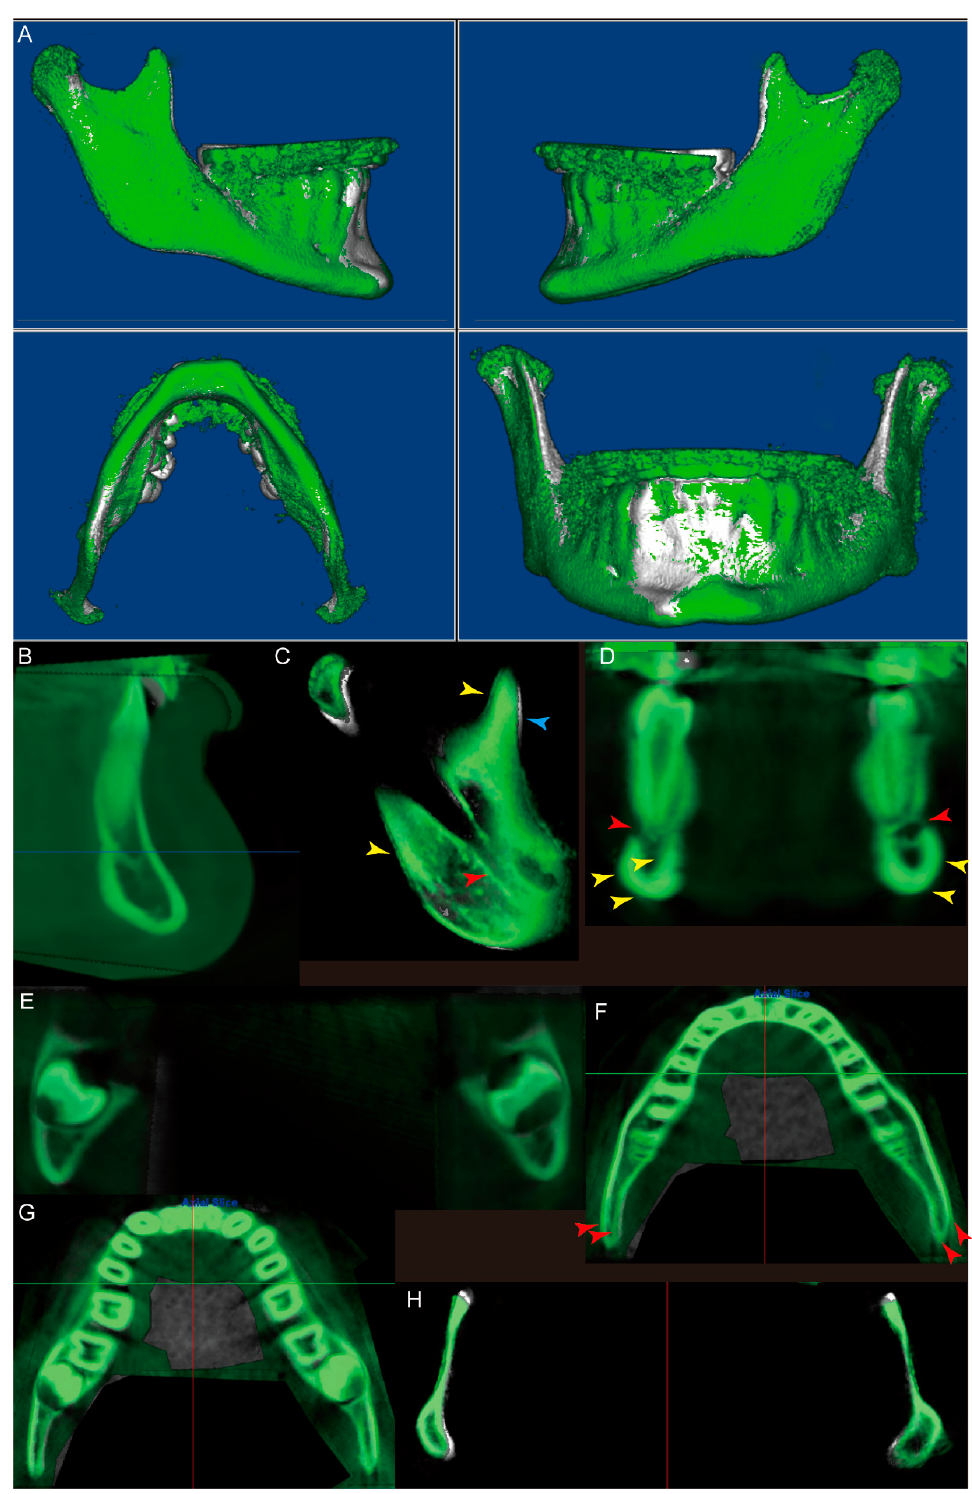
Figure 6. The Dolphin 3D voxel-based superimposition of the initial (white, CBCT #4) and progress (green, CBCT #3) CBCT datasets of the mandible for patient #3. ( A ) The 3D reconstructed surface structure image of the mandible after superimposition. ( B ) Sagittal slice along the facial midline. ( C ) Sagittal slice in the right ramus region. Red arrow: inferior alveolar canal; blue arrow: resorption; yellow arrows: deposition. ( D ) Coronal slice in the first premolar region. Yellow arrows: deposition; red arrows: mental foramen. ( E ) Coronal slice in the third molar region. ( F ) Axial slice at the root apex level. Red arrows: buccally moved cortical plates. ( G ) Axial slice at the cervical level of the teeth. ( H ) Axial slice at the level of the deepest portion of the mandibular